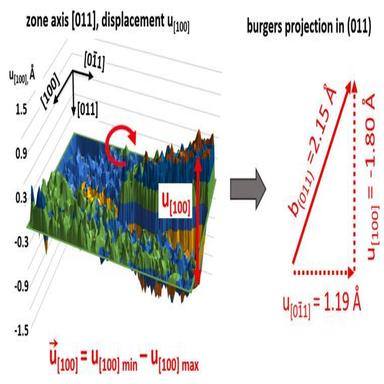
Burgers vector projection in the (011) plane as obtained by TeMA analysis of the experimental STEM-image shown in a).